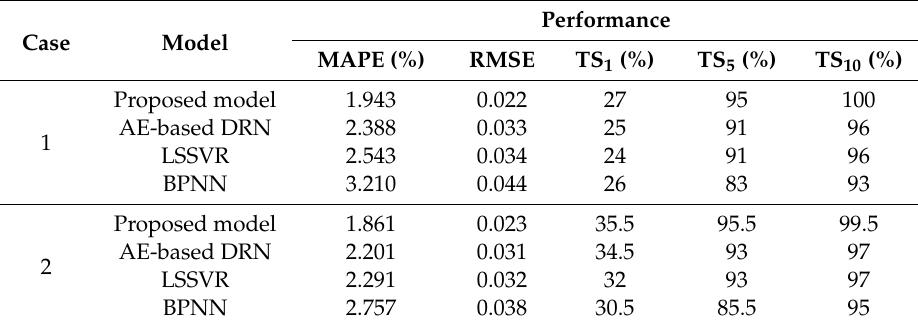
Table 4. Comparison of the prediction performances using different models.